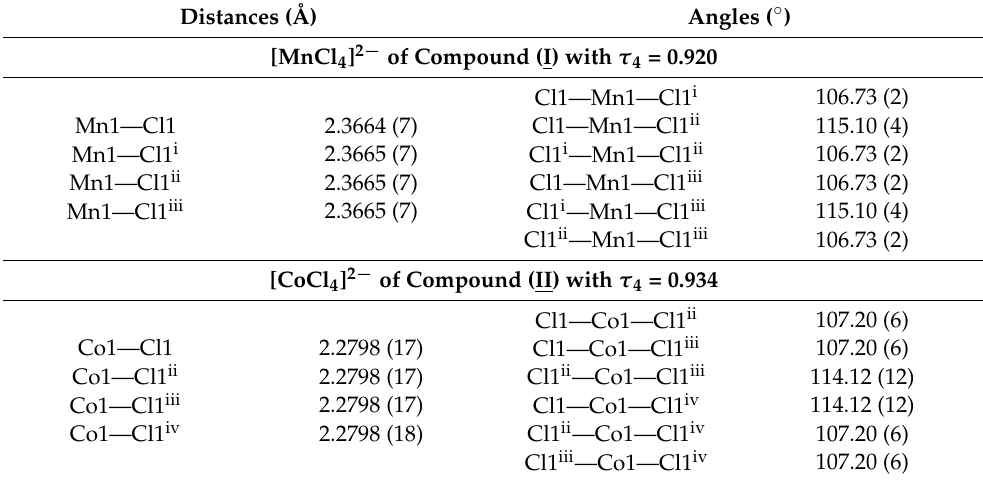
Table 3. The principal interatomic distances (Å) and angles ( ◦ ) of [MnCl 4 ] 2 − and [CoCl 4 ] 2 − . Distances (Å) Angles ( ◦ ) [MnCl 4 ] 2 − of Compound (I) with τ 4 = 0.920 Cl1—Mn1—Cl1 i